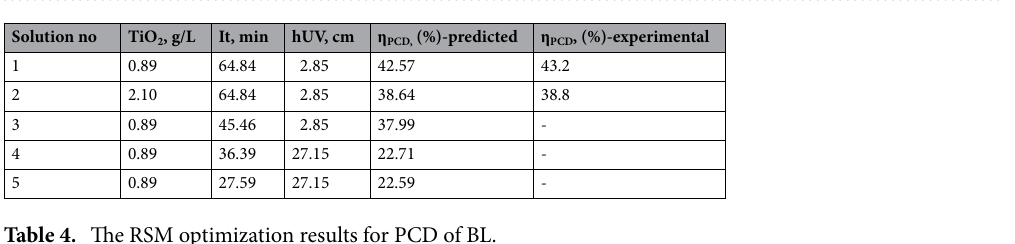
Table 4. The RSM optimization results for PCD of